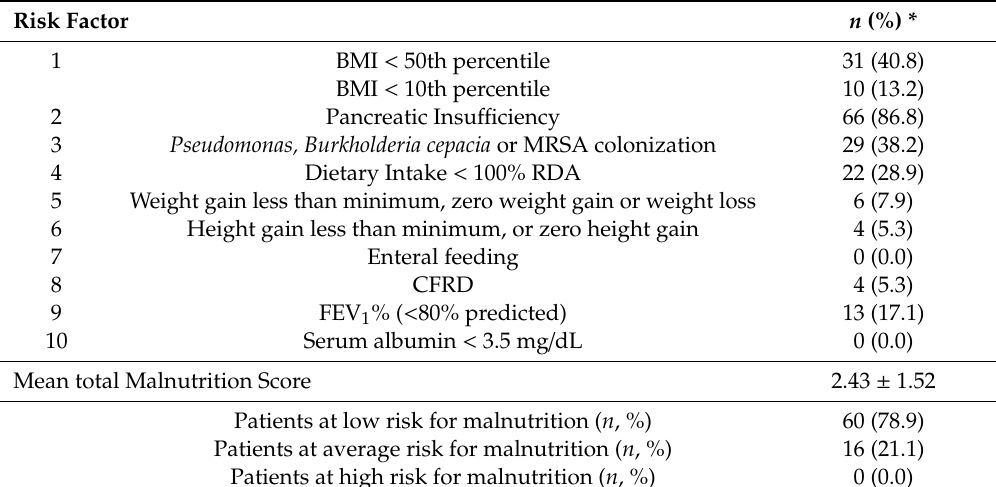
Table 1. Prevalence of malnutrition risk factors, and total malnutrition risk score among participating children, according to the Nutrition Screening Tool for Pediatric Patients with Cystic Fibrosis [15] ( N =